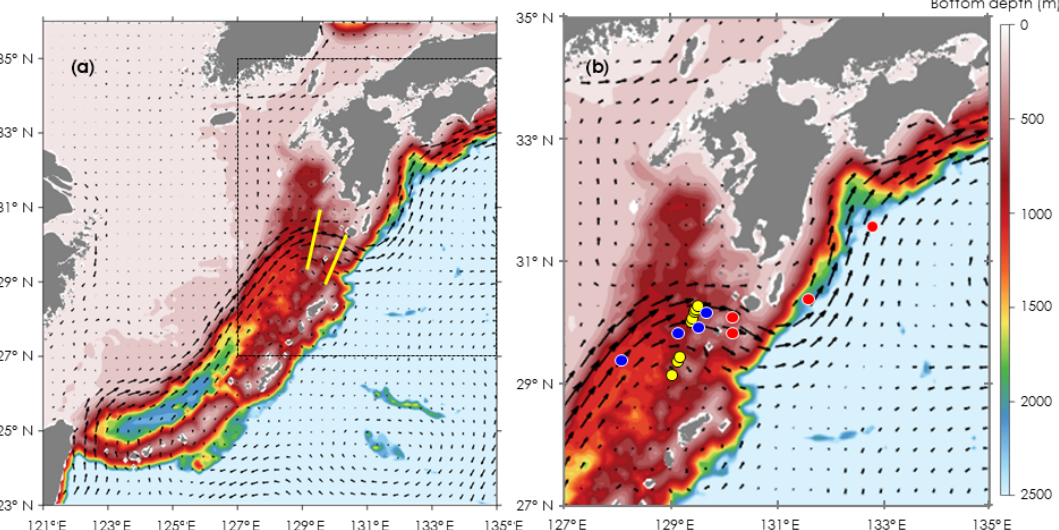
Figure 1. Locations for oceanographic observations and onboard experiments in the Kuroshio Current of the East China Sea (ECS-Kuroshio). (a) Oceanographic observations by Deep SUNA V2 and TurboMAP-L (yellow lines). (b) Onboard experiments for phytoplankton and microzooplankton growth (EXP a : red and blue circles) and for microzooplankton grazing (EXP b : yellow circles). EXP a was conducted in the upstream (blue circles) and downstream Kuroshio (red circles) in the Tokara Strait. Current directions and velocities (arrows) are shown as monthly means during November 2016. Bottom depth (m) is indicated as colored